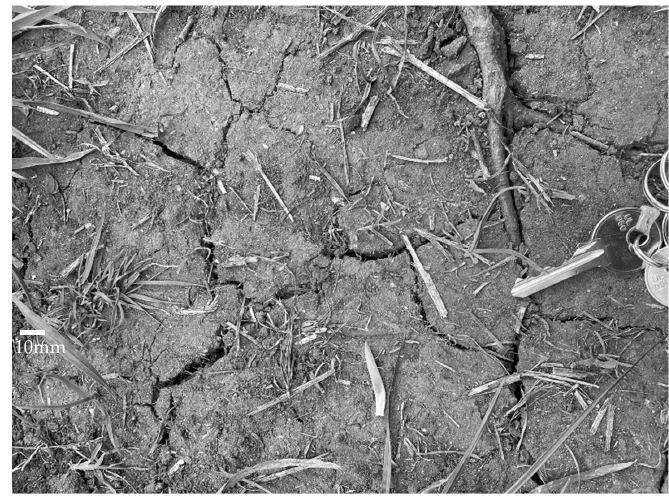
Figure 14. Example of desiccation cracks observed in Baile Hill (York) heritage asset.